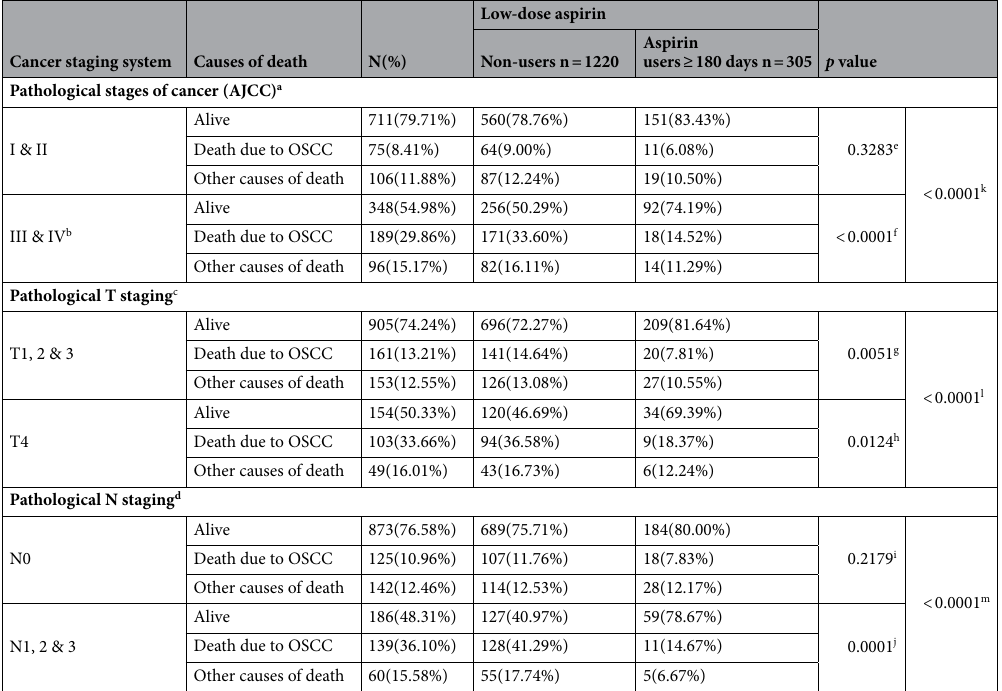
Table 4. Comparing mortality rates between aspirin users (≥ 180 days) and non-users in OSCC patients (n = 1525) according to different types of staging systems. a Pathological AJCC Cancer Staging 7th Edition. b Stages IVa and IVb only. c Pathological T Staging 7th Edition. d Pathological N Staging 7th Edition. e–j Aspirin non-users versus users. k Stages I & II versus III & IV. l T1, 2 & 3 versus T4. m N0 versus N1, 2 &